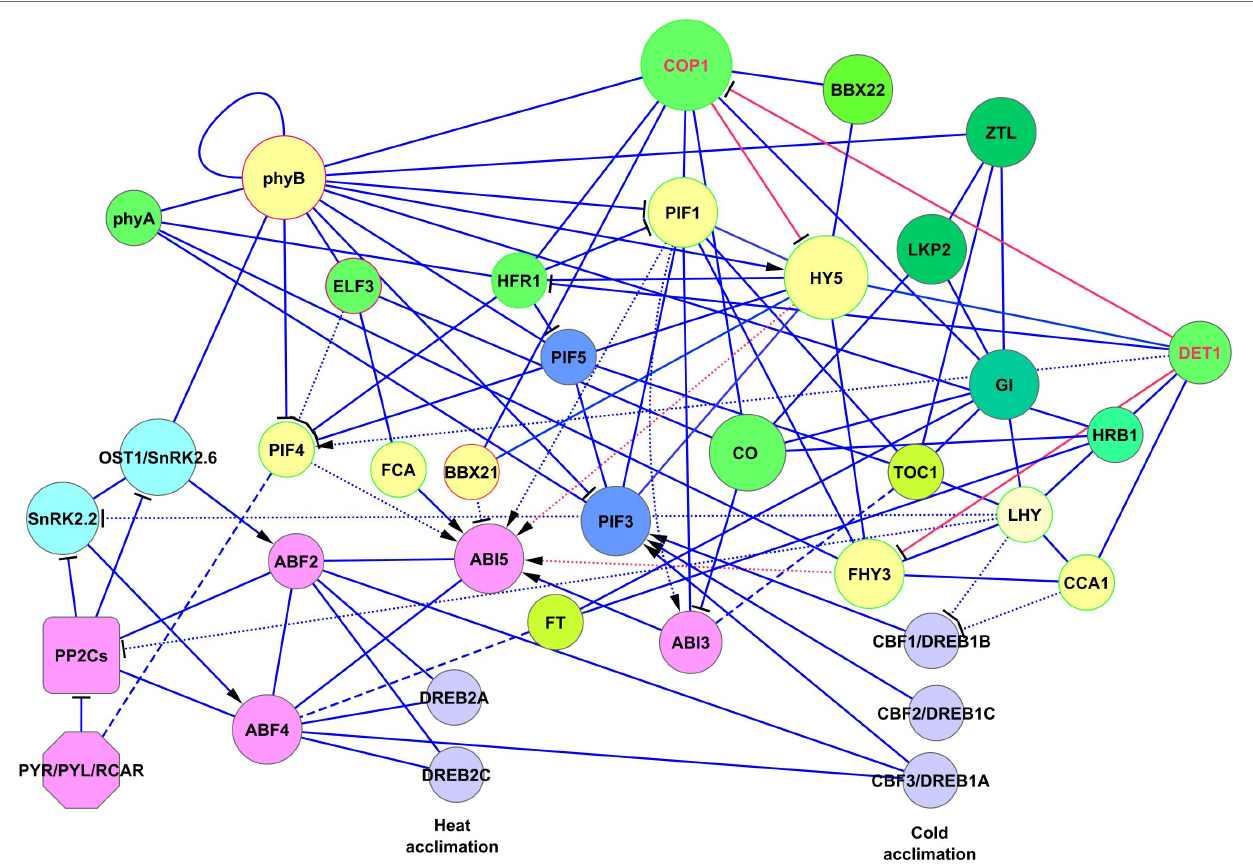
FIGURE 2 | General presentation of the ABA–light signaling network. Yellow circles represent proteins of the light signaling system, physically interacting with ABA proteins (solid lines) or affecting gene expression (dotted lines). Dashed lines represent protein–protein interactions with unknown functions. Other proteins in the light signaling network are shown in green, while ABA proteins are in pink and blue. CBF/DREB proteins are presented in lilac color. Interactions were visualized using the Cytoscape program. The data loaded into the program were obtained from the PAIR database. The protein–protein interactions presented in PAIR were verified using the data from BioGRID, UniProtKB, TAIR, and IntAct databases. Abbreviations: PYR/PYL/RCAR, ABA receptors of the PYR/PYL/RCAR family, PP2Cs, A-type PP2Cs; ABFs, abscisic acid responsive elements-binding factors; ABI3/5, ABA insensitive 3/5; OST1/SnRK2.6, SNF1-related protein kinase 2.6; SnRK2.2, SNF1-related protein kinase 2.2; phyA/B, phytochromes phyA and phyB, PIFs, phytochrome-interacting transcription factors; HY5, transcription factor HY5 (synonym: long hypocotyls 5); CO, CONSTANS; FCA, flowering time control protein; FHY3, far-red elongated hypocotyls 3; BBX21/22, B-box zinc finger transcription factors BBX21 and BBX22; DET1, light-mediated development protein; HRB1, dehydration-induced 19 homologs 7 HRB1/DI19-7; ELF3, early flowering 3; TOC1, two-component response regulator-like APRR1 (synonym: timing of CAB expression 1); FT, flowering locus T; HFR1, transcription factor HFR1 (synonym: long hypocotyl in far-red 1); COP1,